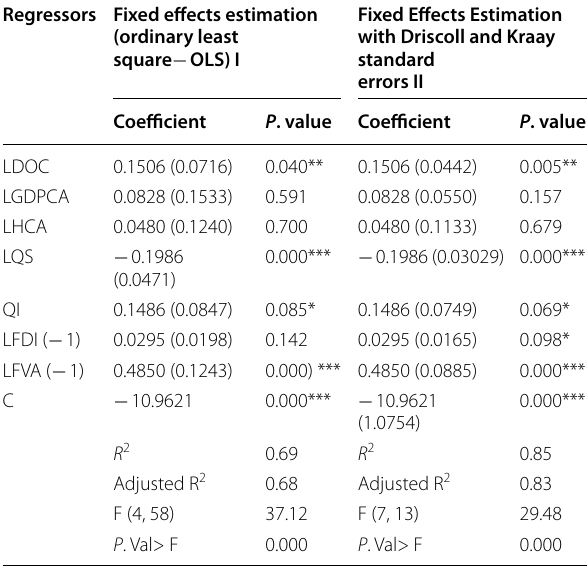
Table 5 Regression model